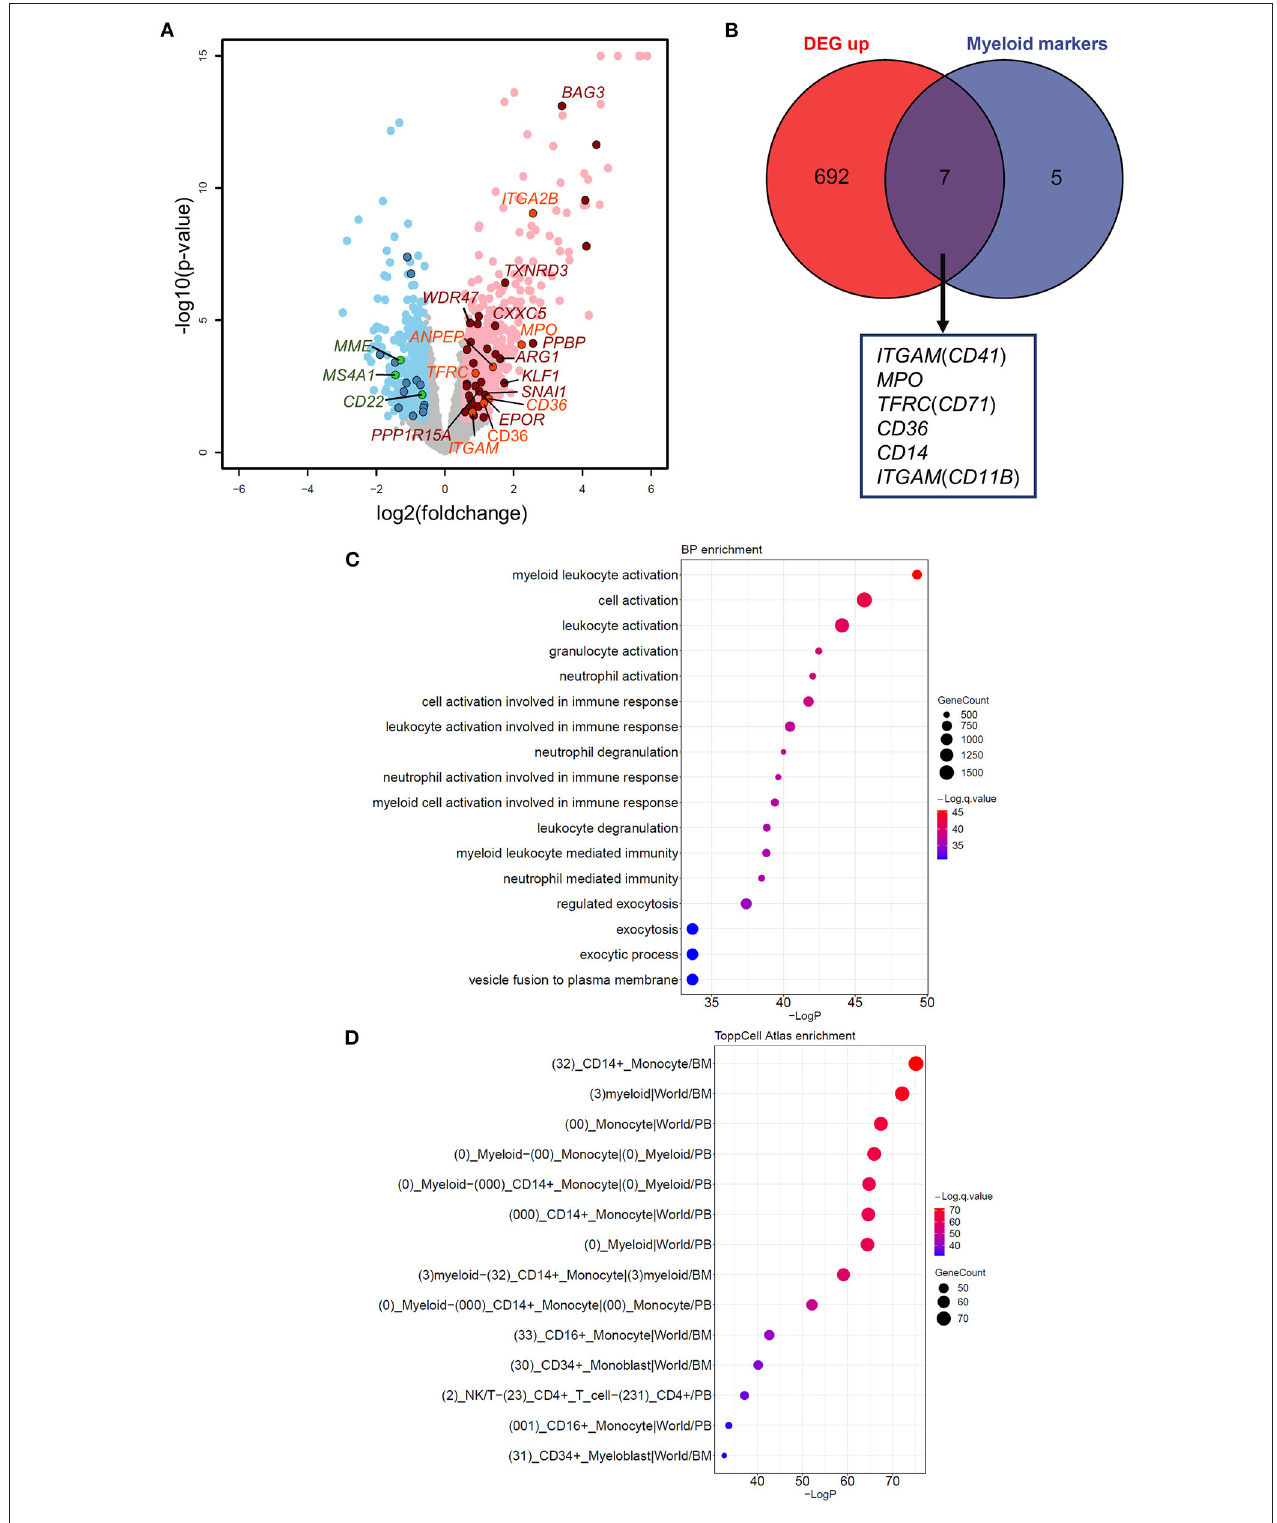
FIGURE 2 | Effects of aberrant GATA2 transcription on B-ALL. (A) Volcano plot illustrating the differentially expressed genes (DEGs) between GATA2 -outlier patients and GATA2 -normal patients. Gray dots indicate genes with no significant differences. Light red and light blue dots indicate 699 up-regulated and 451 down-regulated DEGs, respectively, in GATA2 -outlier patients ( p -value < 0.05 and |FC| > 1.5). DEGs predicted to be bound by GATA2 in motif analysis are highlighted in dark red